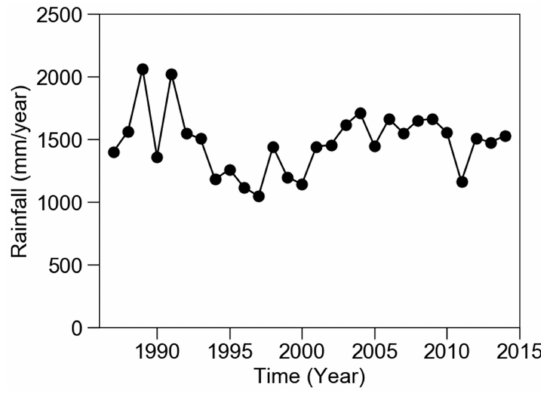
Figure 9. Yearly averaged amounts of precipitation.